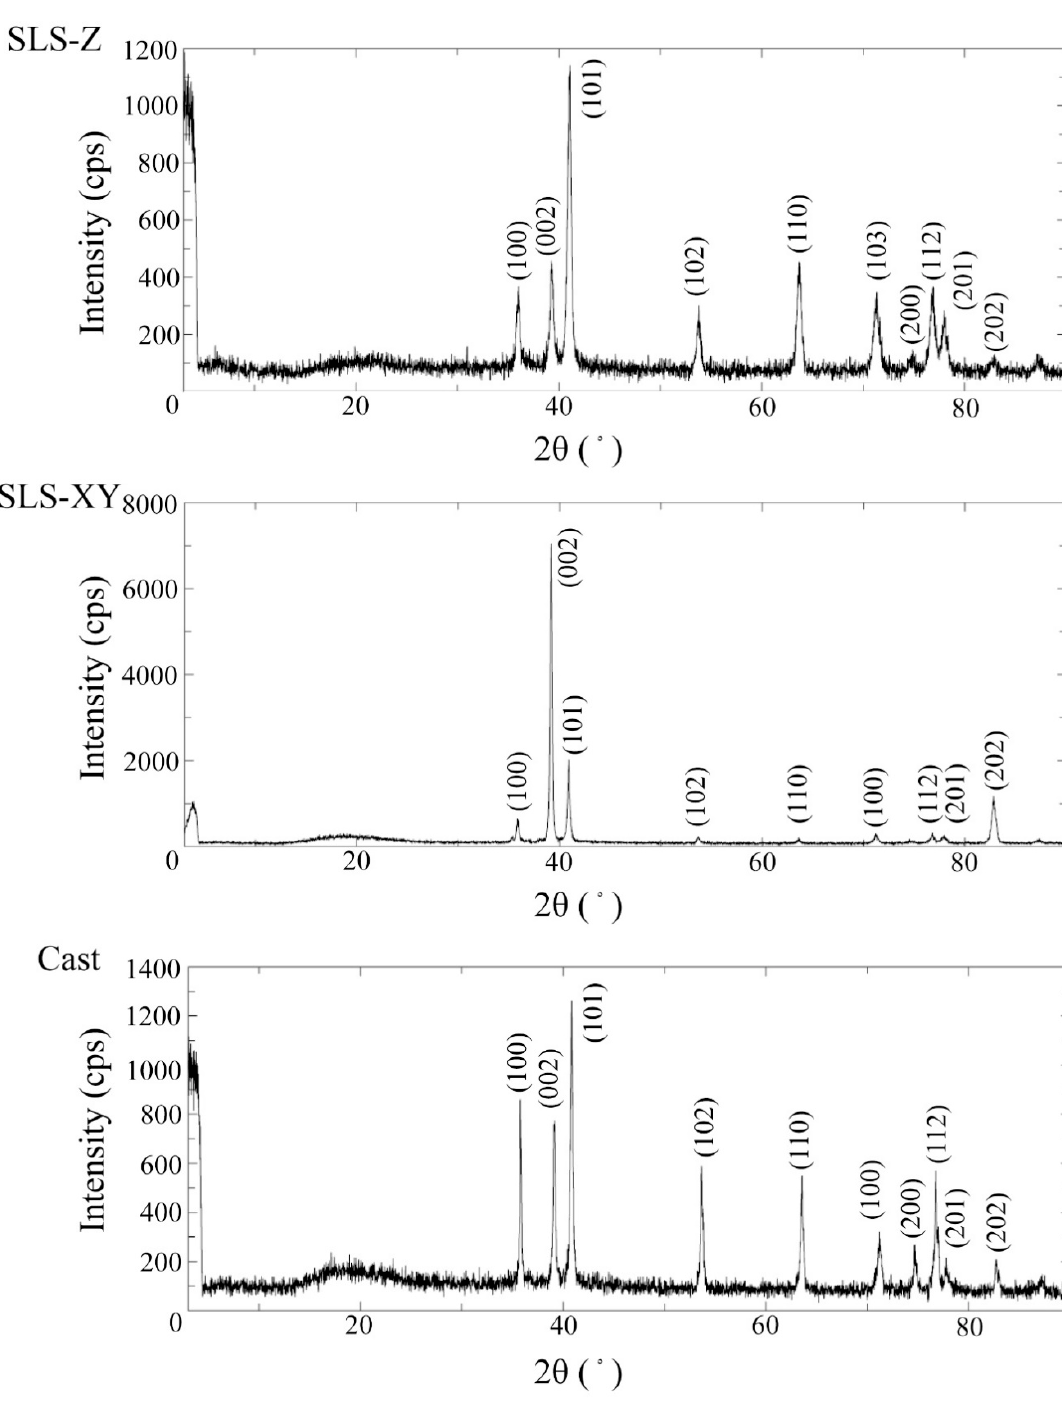
ff raction spectra of the SLS-Z, SLS-XY, and cast pure Ti Figure 8. X-ray diffraction spectra of the SLS-Z, SLS-XY, and cast pure Ti specimens. Figure 8. X-ray di